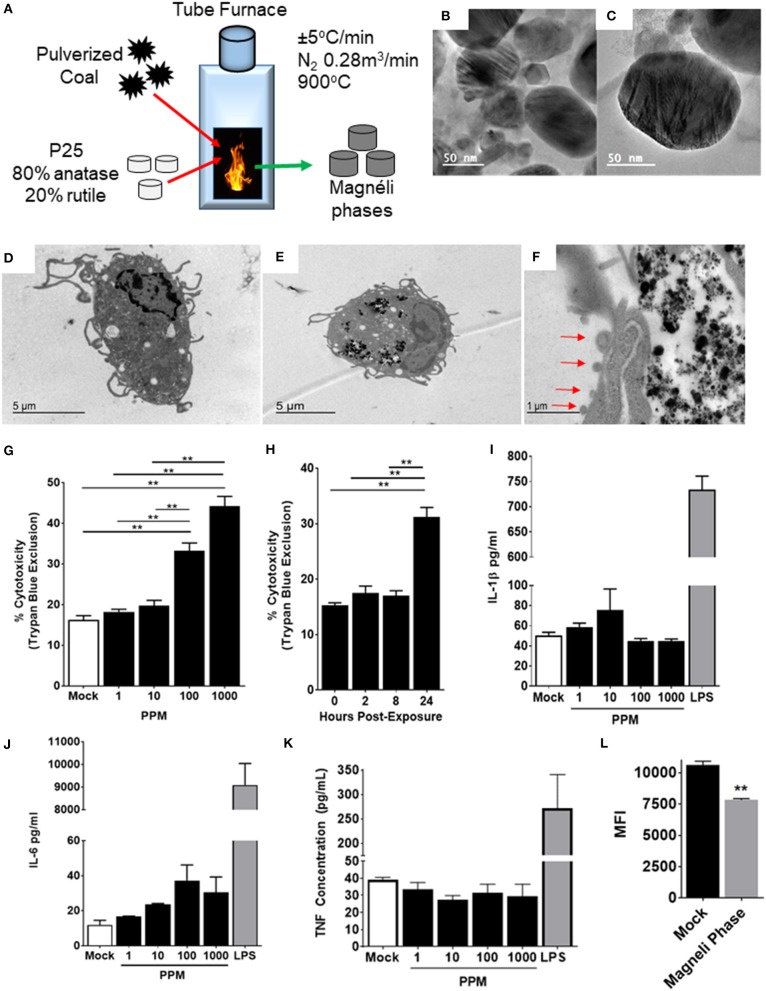
Magnéli phase phagocytosis results in increased cell death in bone marrow-derived macrophages. (A–C) Characterization of Magnéli phases used in this study. (A) Schematic illustrating Magnéli phase generation. (B,C) TEM images of Magnéli phases formed by annealing P25 TiO2 nanoparticles with coal in a pure N2 atmosphere for 2 h at 900°C. Electron diffraction patterns were characteristic of Magnéli phases and confirmed these as predominately Ti6O11 particles. Particles were between 10 and 200nm in size. (D) Un-treated bone marrow-derived macrophages (1 × 106 cells/well) and (E) macrophages treated with Ti6O11 (1, 10, 100, or 1,000 ppm) were visualized using TEM (Scale bar: 5 μm). Magnéli phases appear as punctate dark dots in the macrophages and are concentrated in phagolysosomes. (F) Macrophages containing Magnéli phases demonstrate morphological features consistent with apoptosis, including cell shrinking and membrane blebbing (red arrows) (Scale bar: 1μm). (G,H) Cytotoxicity was evaluated using trypan blue exclusion (G) across the Ti6O11 dose range and (H) at 100 ppm over a 24 h time course. (I,J) Inflammation was evaluated by assessing the production of pro-inflammatory cytokines, such as (I) IL-1β, (J) IL-6, and (K) TNF in the cell free supernatant following exposure to different doses of Magnéli phases. (L) Macrophage function was evaluated by assessing the ability of macrophages to phagocytose fluorescent Escherichia coli 24 h post-exposure to 100 ppm Magnéli phases. Data are expressed as mean ± SEM (n = 3 independent experiments). **p < 0.01.